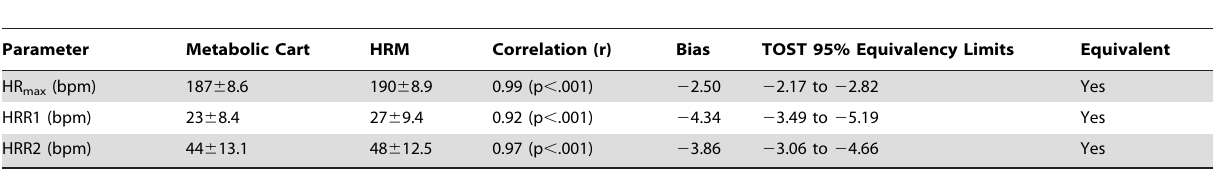
Upper and lower equivalency bounds were defined as 6 bpm. Bias: Difference between metabolic cart and HRM parameters.